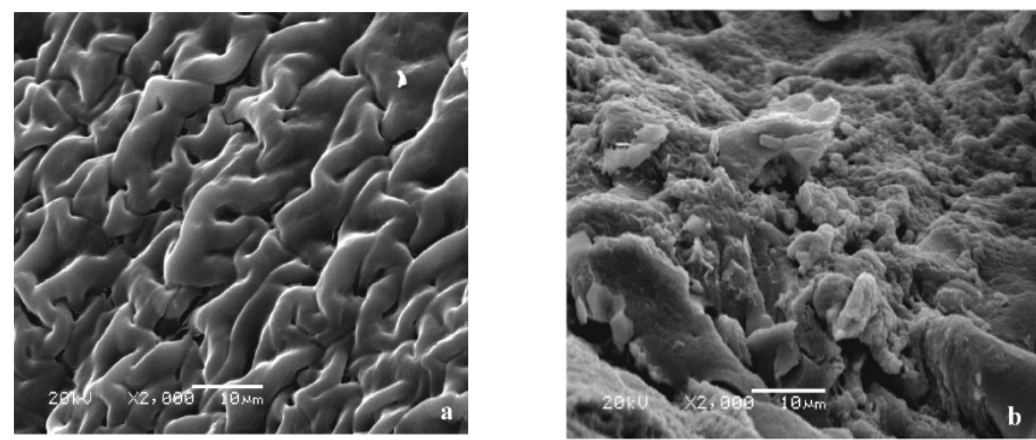
Figure 3. SEM morphologies of PVP/AAc before (a) and after (b) adsorption of Pb(II) (Adapted from